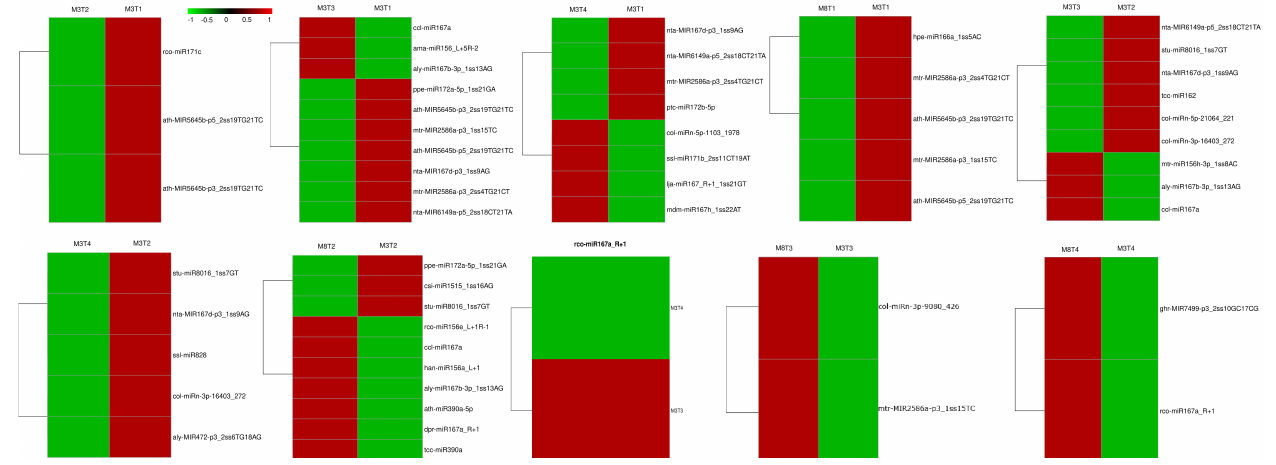
Figure 4. Heatmap of differentially expressed miRNAs among different